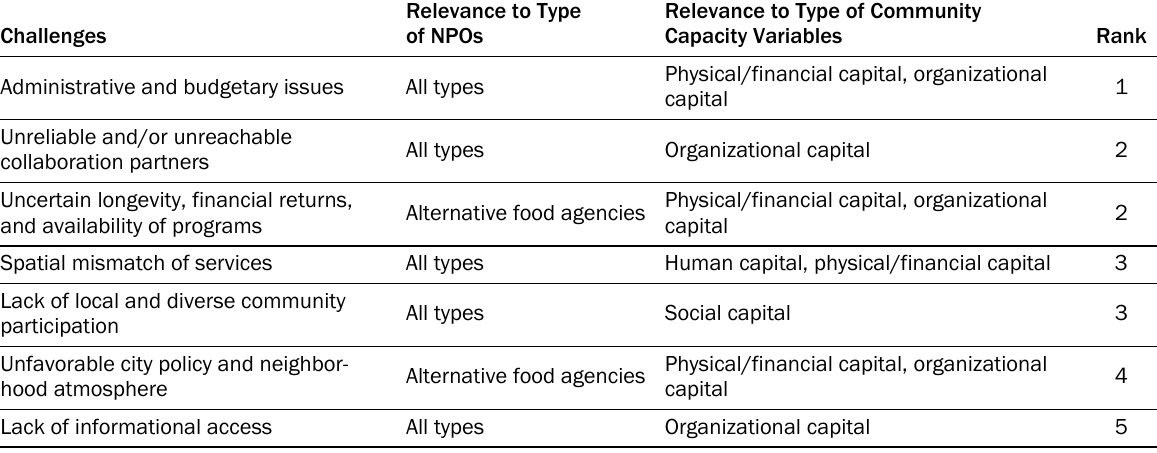
Table 6. Challenges Faced by Nonprofit Organizations (NPOs), Ranked by Importance